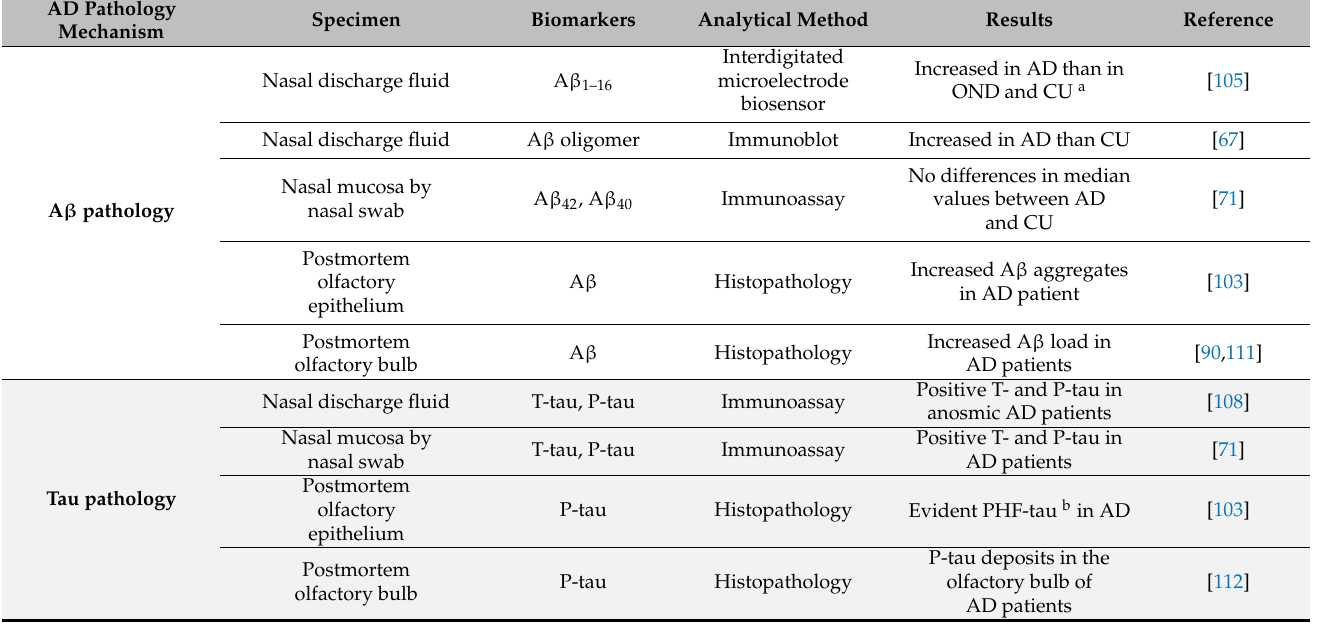
Table 7. Summary of core AD biomarkers in the olfactory